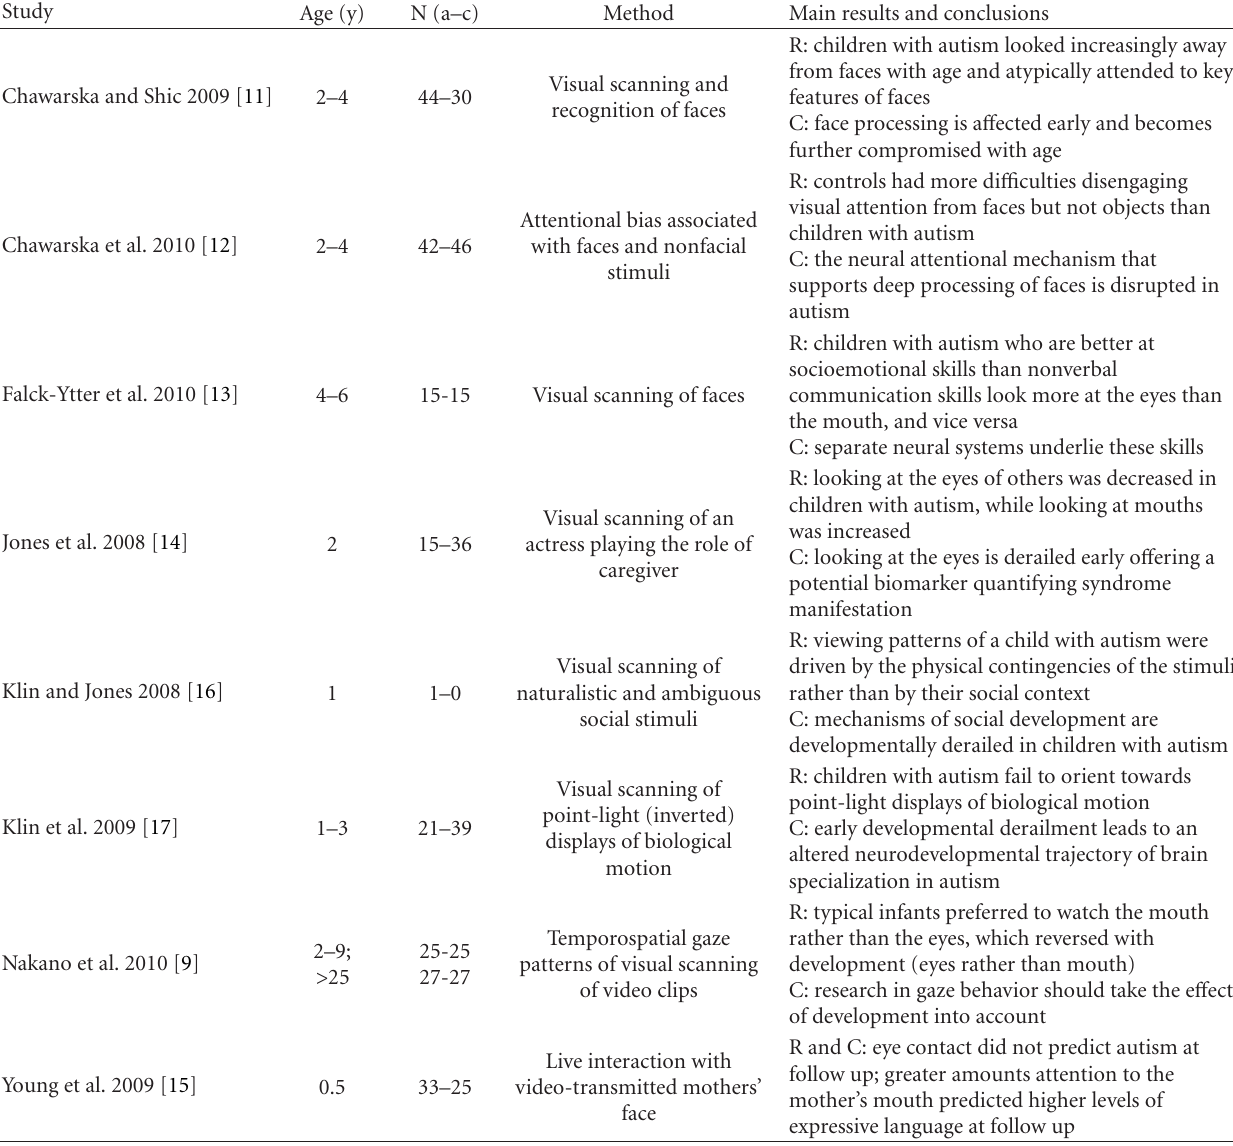
Table 1: Overview of recent influential eye-tracking studies in very young